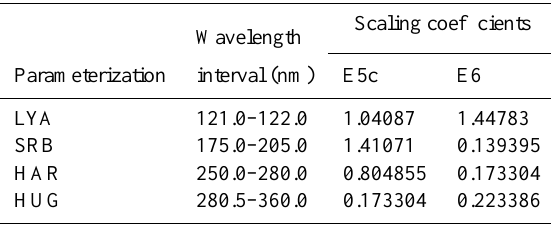
Table 2. Wavelength intervals and scaling coefficients of the extra heating